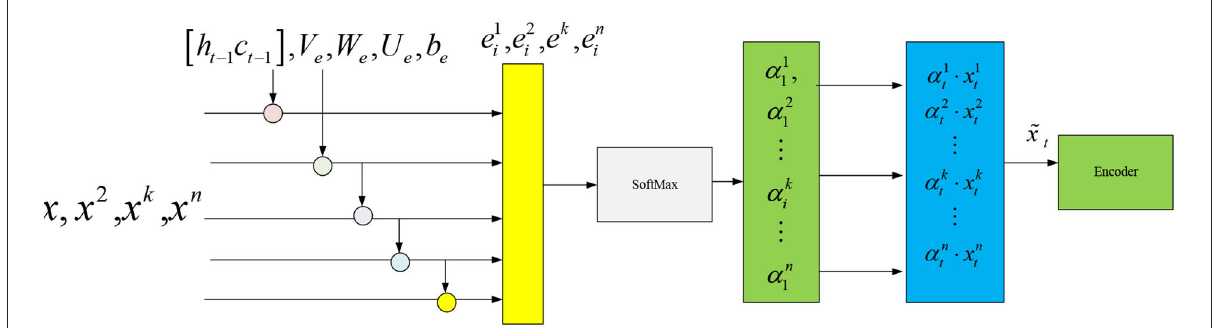
FIGURE6 Input AM module calculation process.